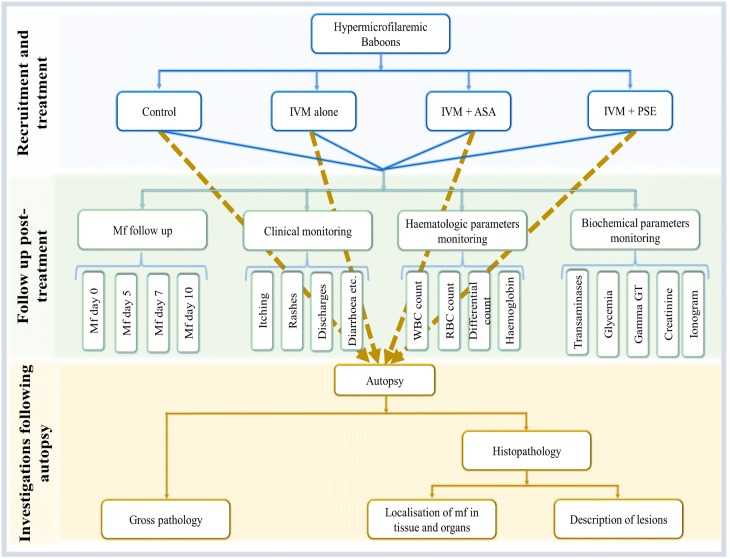
The study design.